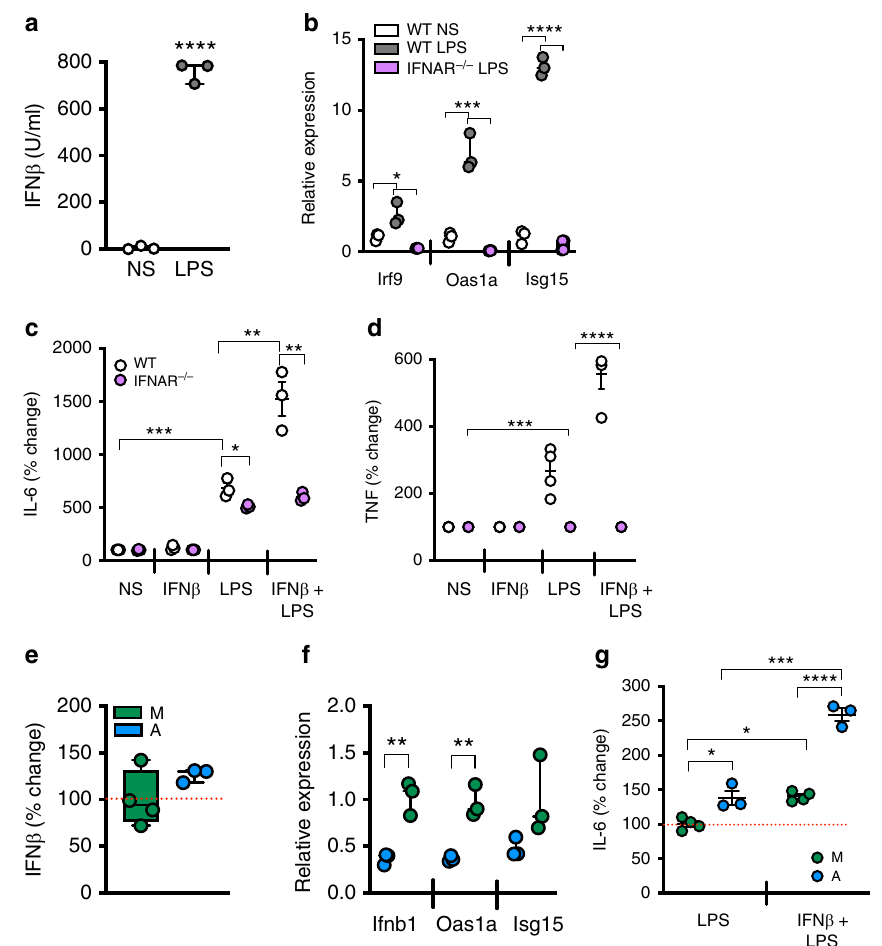
Fig. 1 IFN β /IFNAR axis exacerbates adipocyte immune potential. Primary adipocytes or bone-marrow-derived macrophages isolated from chow-diet-fed WT and IFNAR − / − mice were treated with saline (NS), IFN β (250 U/ml) or LPS (100 ng/ml) as indicated. a Quanti fi ed IFN β protein levels in adipocyte culture supernatants by type I IFN activity assay. b mRNA expression by qPCR of indicated type I IFN axis genes in adipocytes, relative expression to WT NS. c IL-6 and d TNF protein levels in adipocyte culture supernatants quanti fi ed by ELISA; % change over NS. e Quanti fi ed IFN β protein levels in adipocytes and macrophage culture supernatants by type I IFN activity assay; % change to macrophage. f mRNA expression of indicated type I IFN axis genes by qPCR in adipocytes and macrophage, relative expression to macrophage. g IL-6 protein levels in stimulated macrophages and adipocytes under indicated conditions quanti fi ed by ELISA; % change to LPS-stimulated macrophages. a − d Representative of three independent experiments, n = 3 − 4/condition. e − g Representative of three independent experiments, n = 3 − 4/condition. For bar graphs, data represents mean ± SEM. a − g For box plots, the midline represents the mean, boxes represent the interquartile range and whiskers show the full range of values. a − d Unpaired two-tailed Student ’ s t